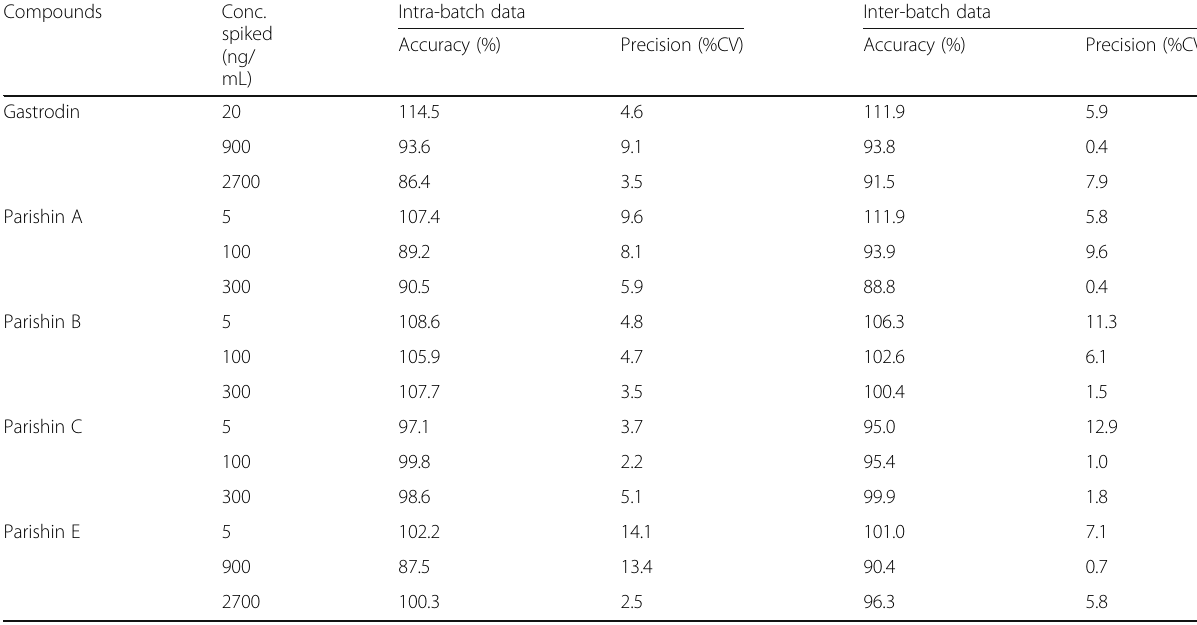
Table 2 Intra-batch ( n = 5) and inter-batch ( n = 15) accuracy and precision for the analysis of the five analytes in rat plasma Compounds Conc. spiked (ng/